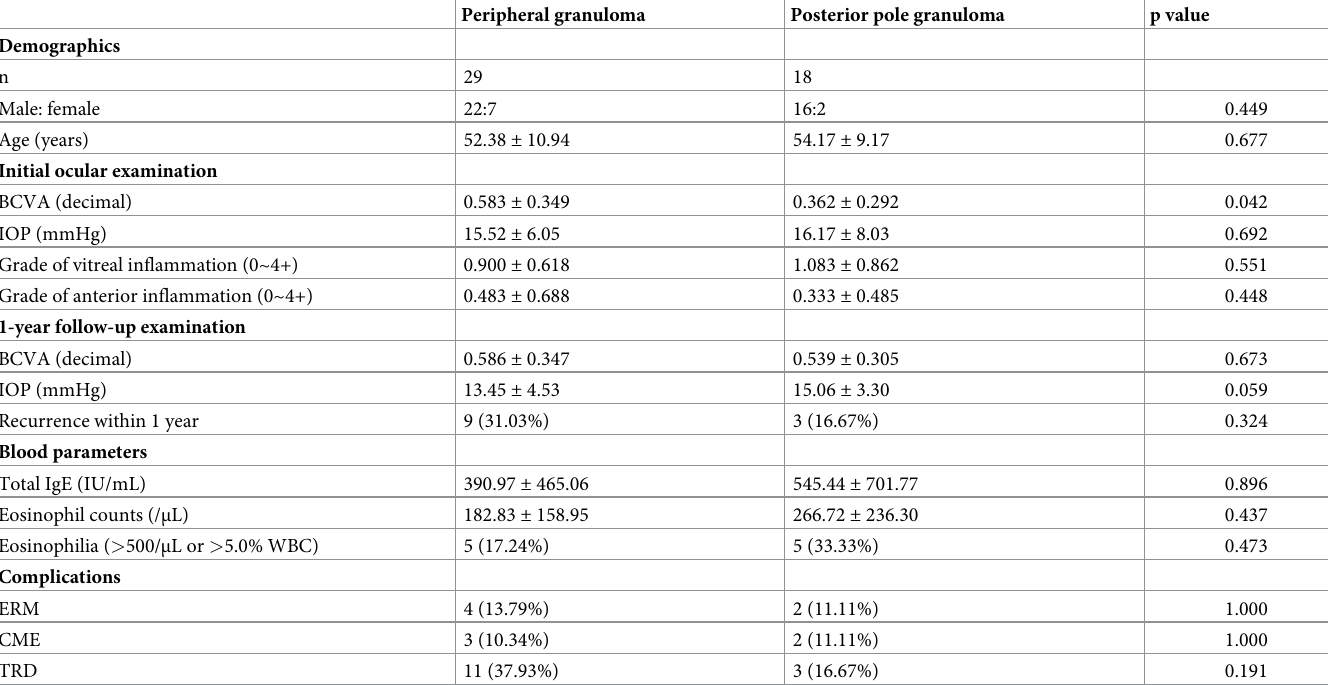
Table 1. Comparison of the peripheral granuloma and posterior pole granuloma